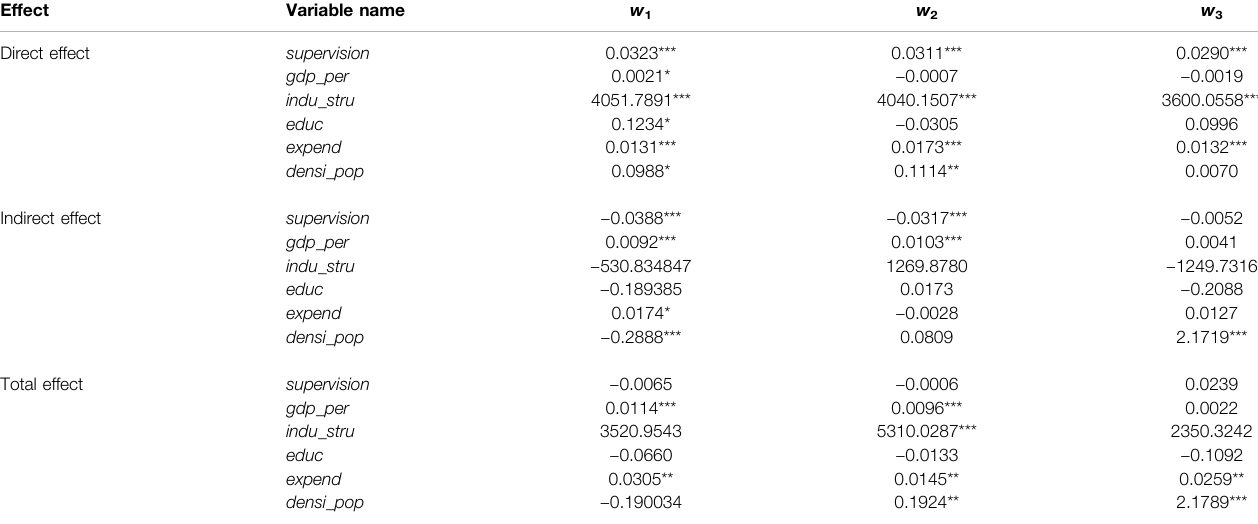
TABLE 2 | Direct and indirect effect estimation results of spatial Durbin